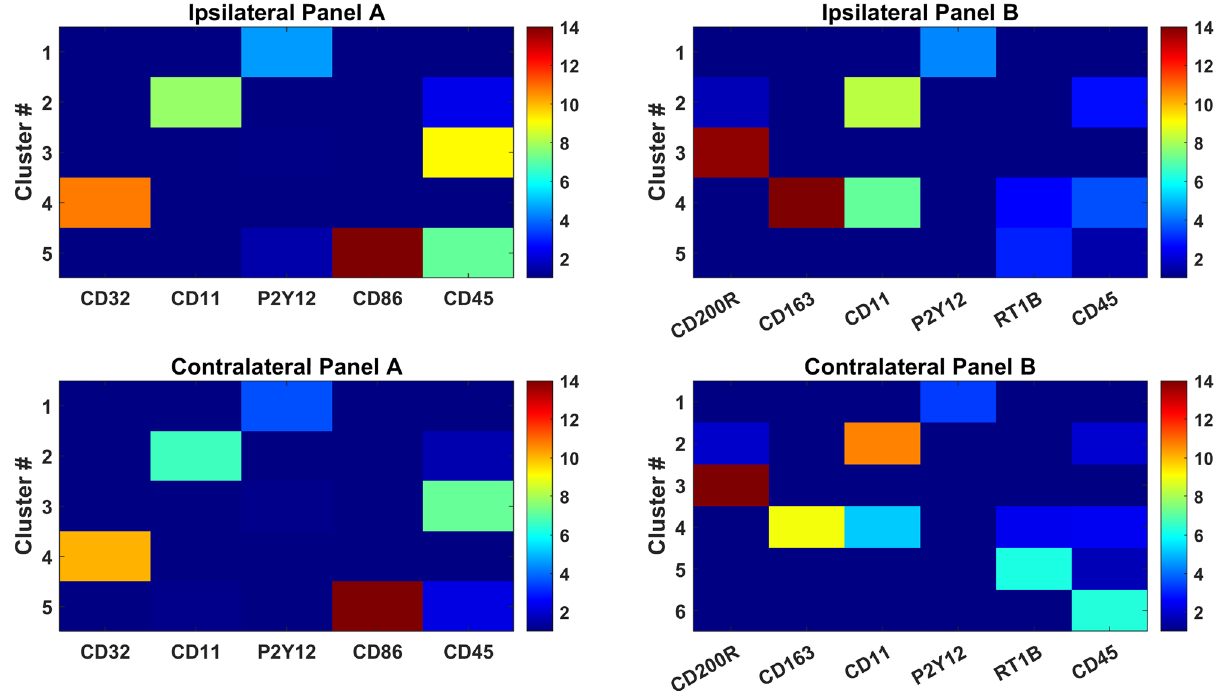
Figure 2. Cluster signatures over Panel A and B markers. Median expression values for ipsilateral clusters and contralateral clusters depict the most prominent markers associated with each